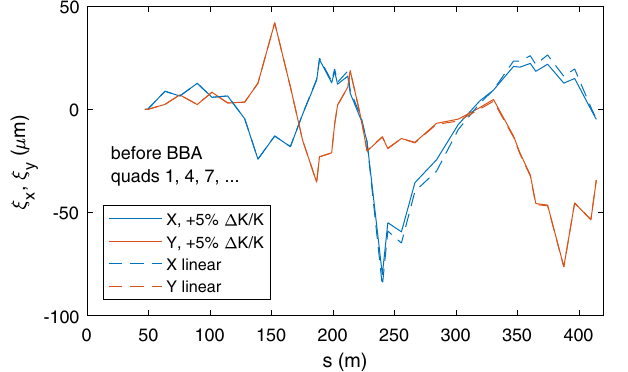
FIG. 3. Singular values of the horizontal and vertical response matrices of the induced trajectory shift by a 5% increase of the strengths of group 1 quadrupoles with respect to the corrector magnets.